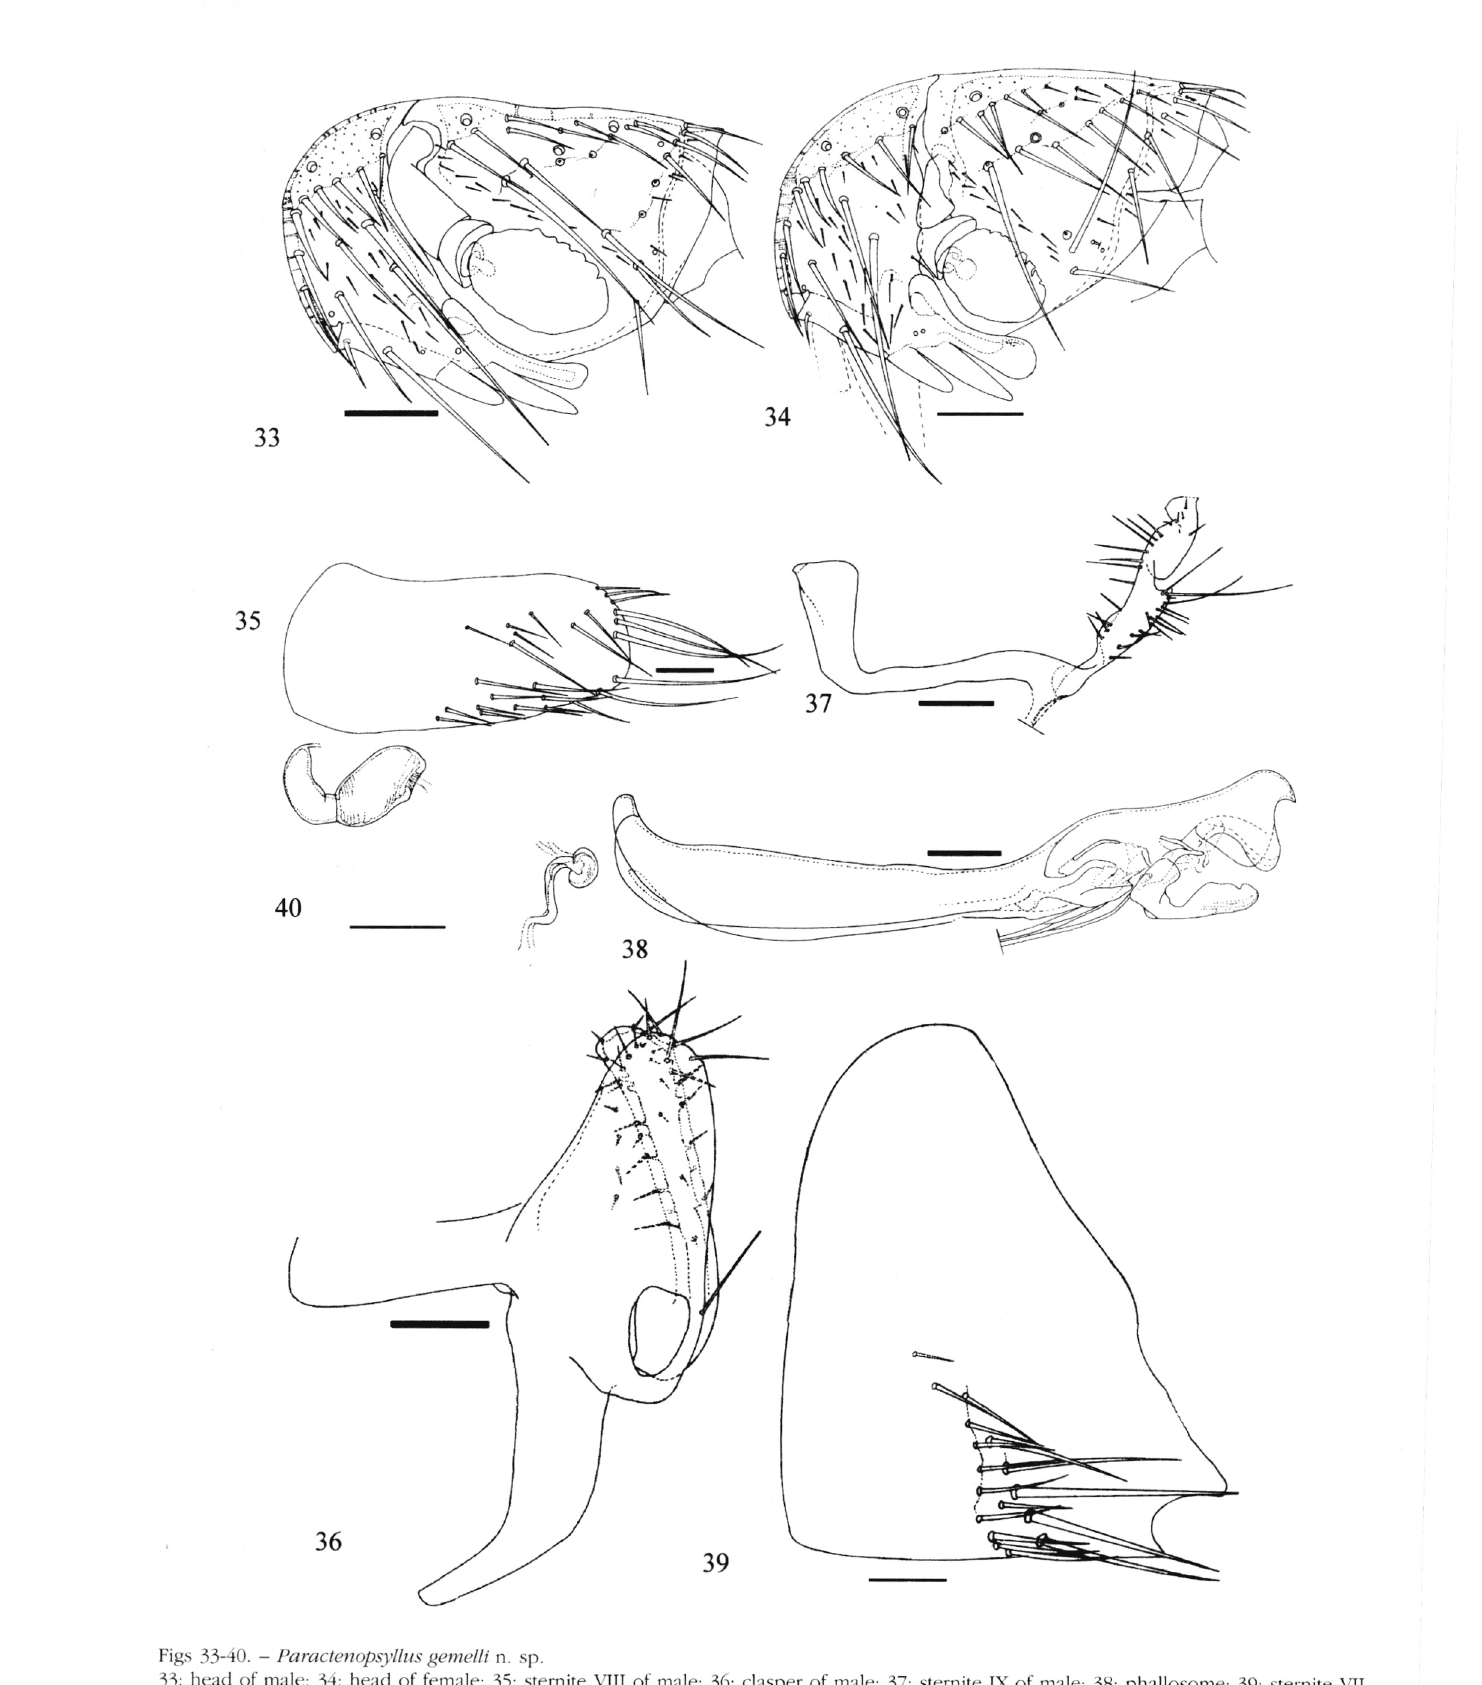
Figs 33-40. - Paractenopsyllus gemelli n. sp. 33: head of male; 34: head of female; 35: sternite VIII of male; 36: clasper of male; 37: sternite IX of male; 38: phallosome; 39: sternite VII of female; 40: spermatheca and ductus bursae. All scale bars = 0,1 mm. 68-